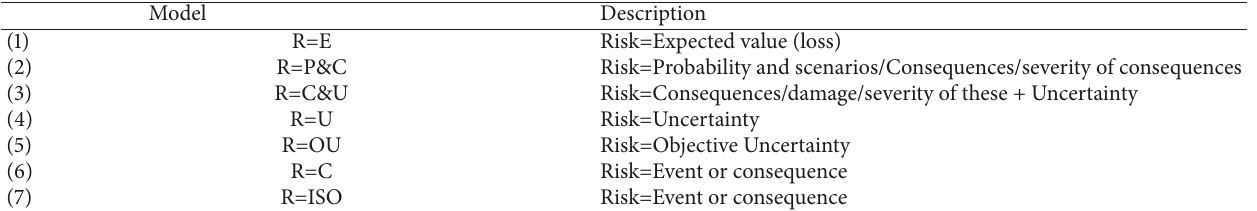
Table 4: Main models on risk used in the professional and scientific fields (adapted from [16]).